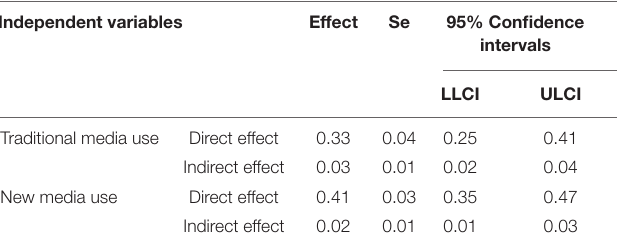
TABLE 5 | Direct and indirect effects of media use on the purchase of private medical